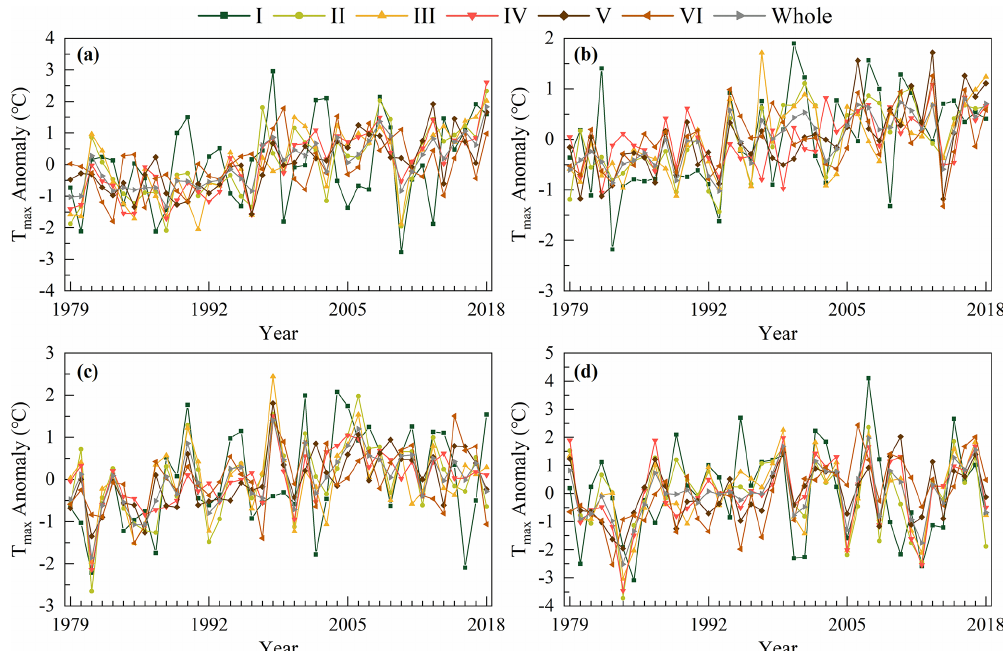
Figure 11. Changes of T max anomalies in various regions of China in spring (a) , summer (b) , autumn (c) and winter (d) during 1979–2018. Table 4. Seasonal change rate of T max in various regions of China from 1979 to 2018. I II III IV V VI Whole Spring 0.035 0.063 ∗∗ 0.072 ∗∗ 0.063 ∗∗ 0.051 ∗∗ 0.026 ∗ 0.048 ∗∗ Summer 0.040 ∗∗ 0.035 ∗∗ 0.033 ∗∗ 0.022 ∗∗ 0.039 ∗∗ 0.020 ∗ 0.031 ∗∗ Autumn 0.039 ∗ 0.024 0.014 0.025 ∗∗ 0.035 ∗∗ 0.025 ∗ 0.023 ∗∗ Winter 0.009 − 0 . 002 0.027 0.037 0.034 ∗ 0.058 ∗∗